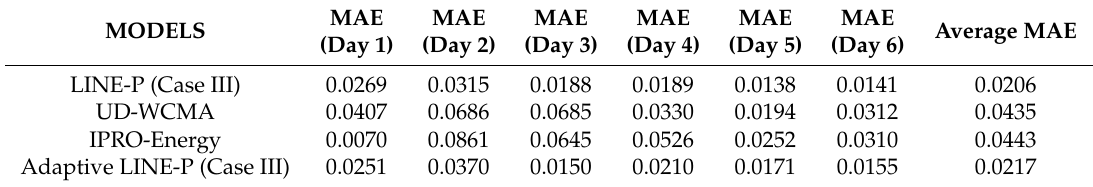
Table 6. Error comparison of prediction models based on MAE for the PG&E solar energy profile.